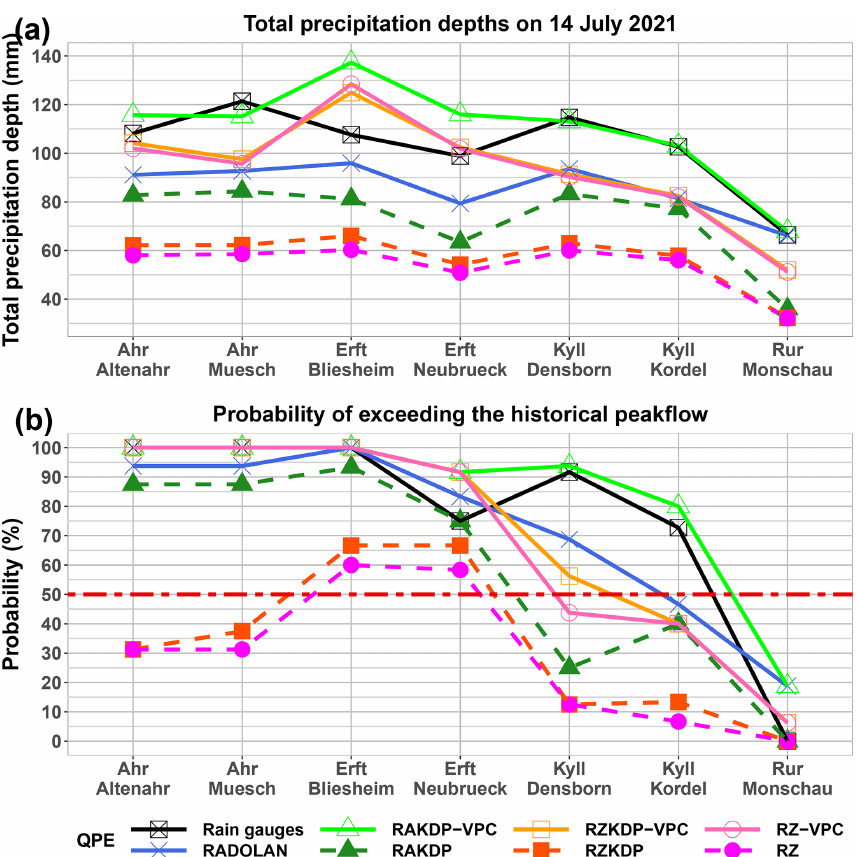
Figure 7. (a) Total precipitation depth for 14 July 2021 from the eight QPE products for each of the seven catchments and (b) resulting probabilities of overpassing the highest measured peak flow prior to July